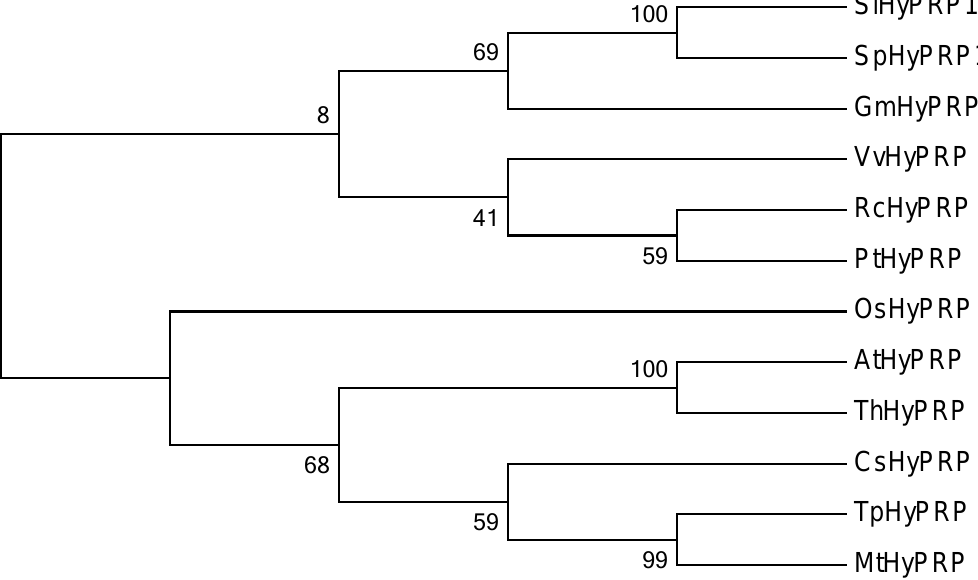
Figure 1. Phylogenetic analysis of HyPRP1 and homologous gene sequences from ten representative species. Species and GenBank accession numbers are shown as previously described [22]. The phylogenetic tree obtained by the neighbor-joining method and 1000 bootstrap replicates. The scale indicates branch length, and bootstrap values represent the divergence of each